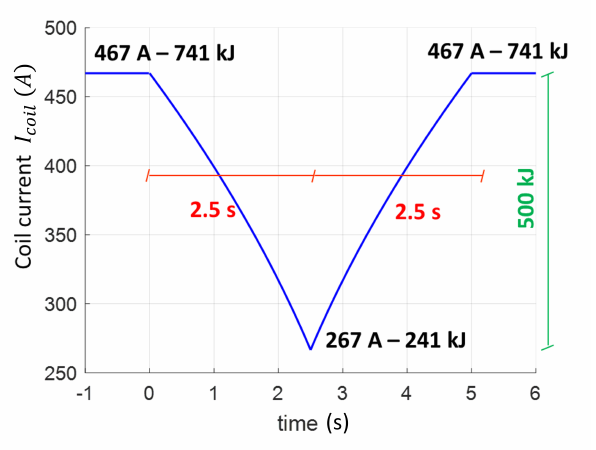
Figure 3. The current (blue trace) of the SMES coil during one discharge–charge cycle at full power P = 200